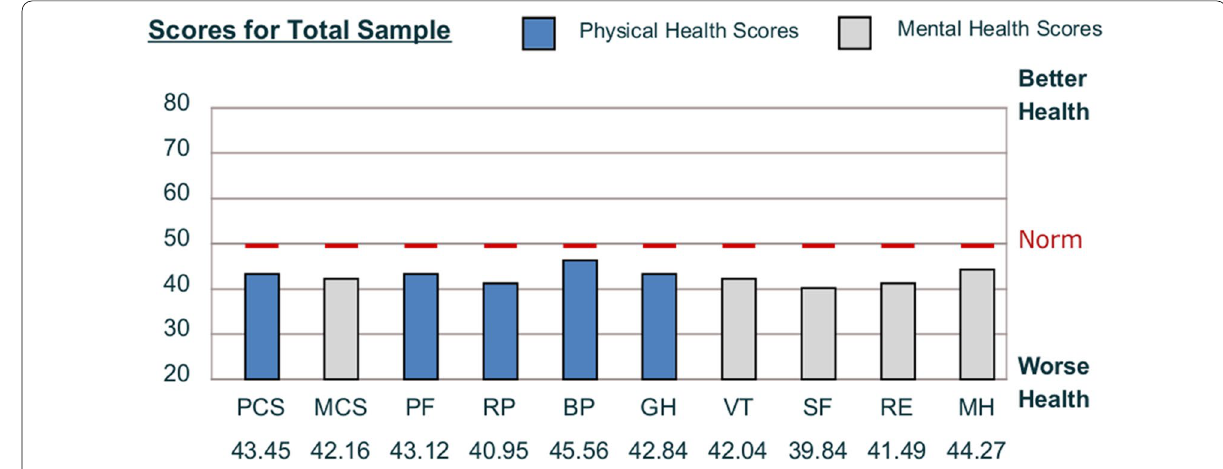
Fig. 1 Mean score comparison to general population on the